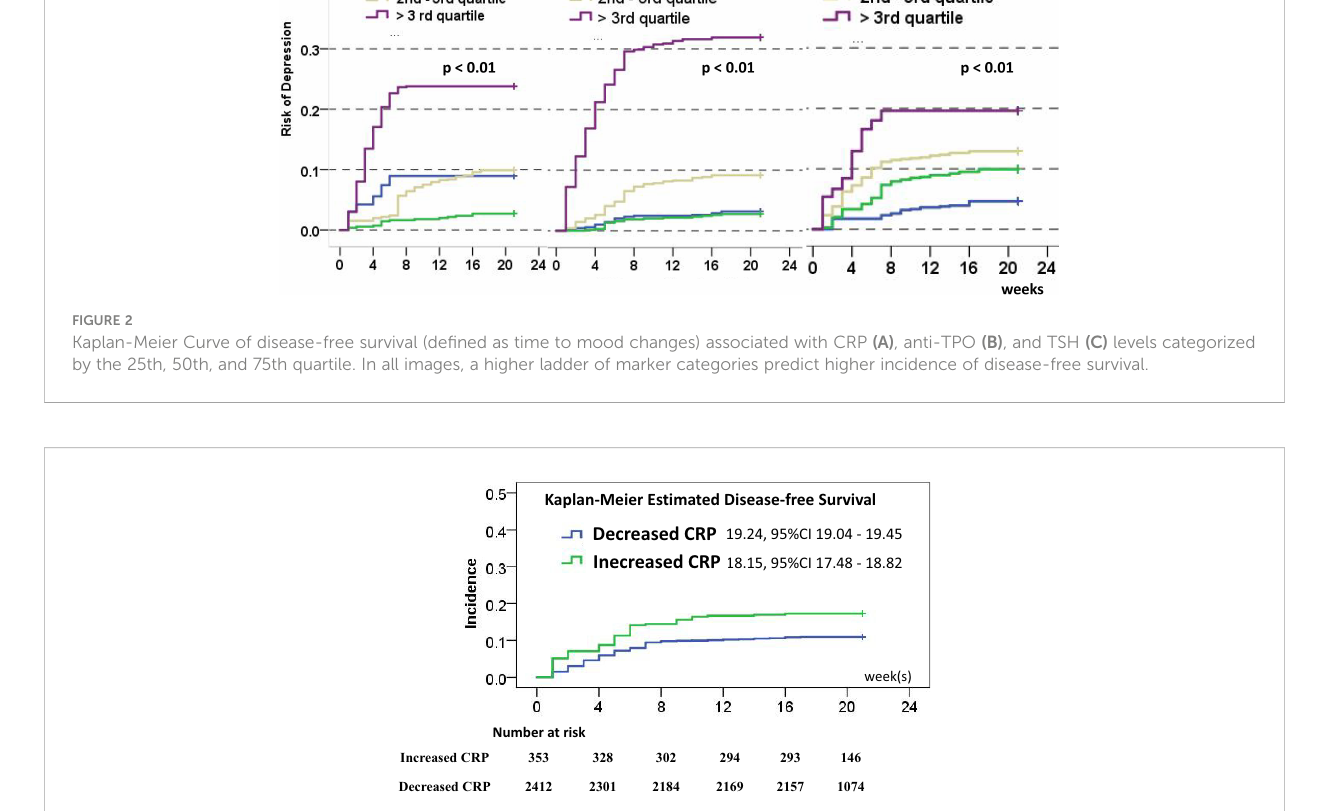
FIGURE 3 Disease-free survival rate estimates after vaccination associated with CRP changes, and the risk of mood changes was signi fi cantly different (p < 0.01).